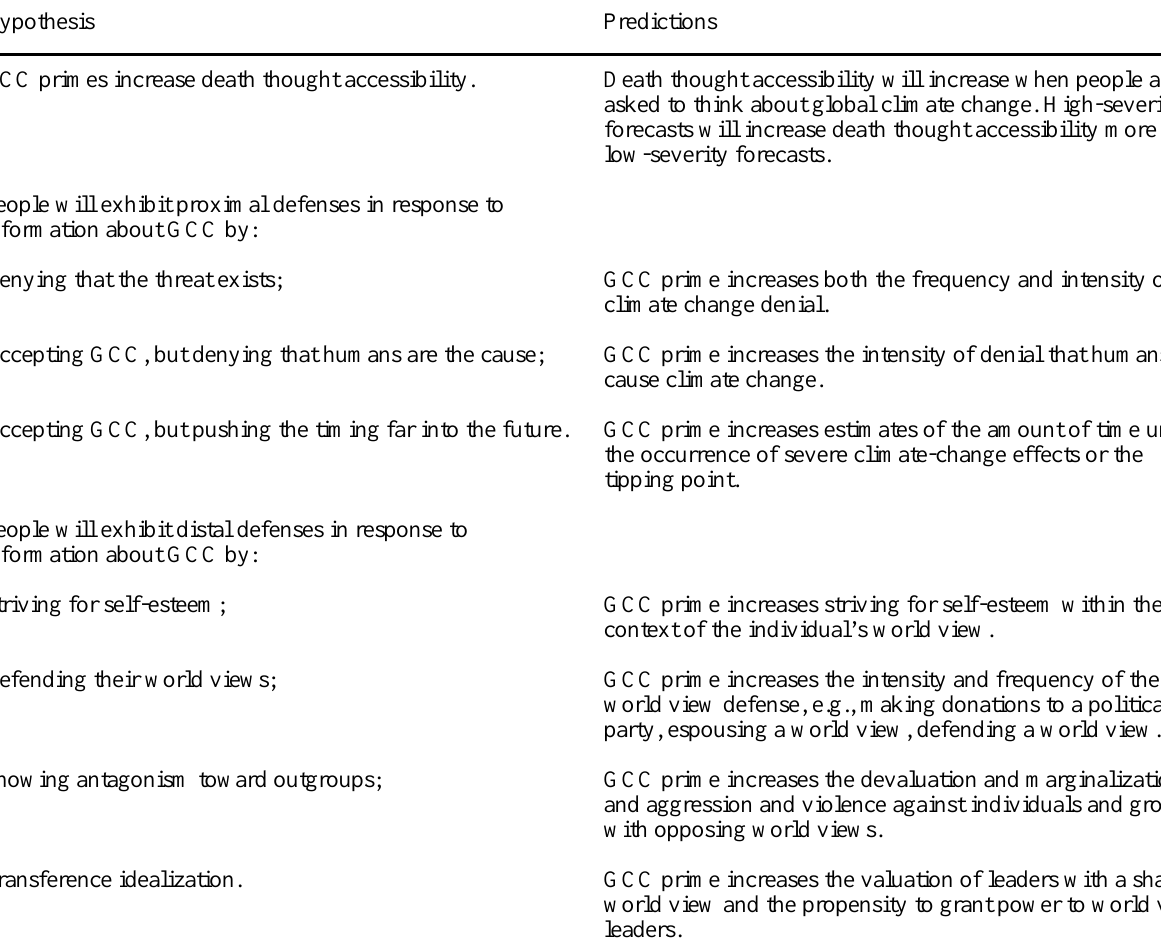
Table 1 . Terror management theory predictions for how thinking about mortality in association with climate change (GCC) affects people’s behavior. GCC primes include a range of stimuli that cause people to think about the impacts of and risks associated with global climate change. Hypothesis Predictions GCC primes increase death thought